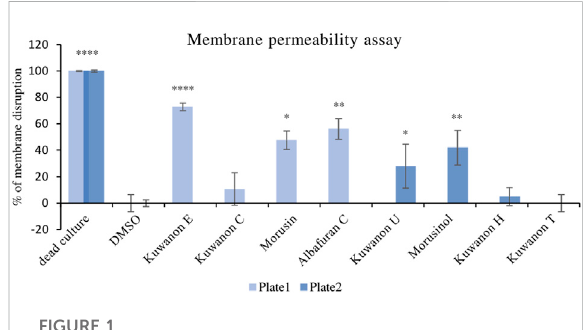
FIGURE 1 Graphical evaluation of the membrane disruption assay of prenylated phenolics against MRSA